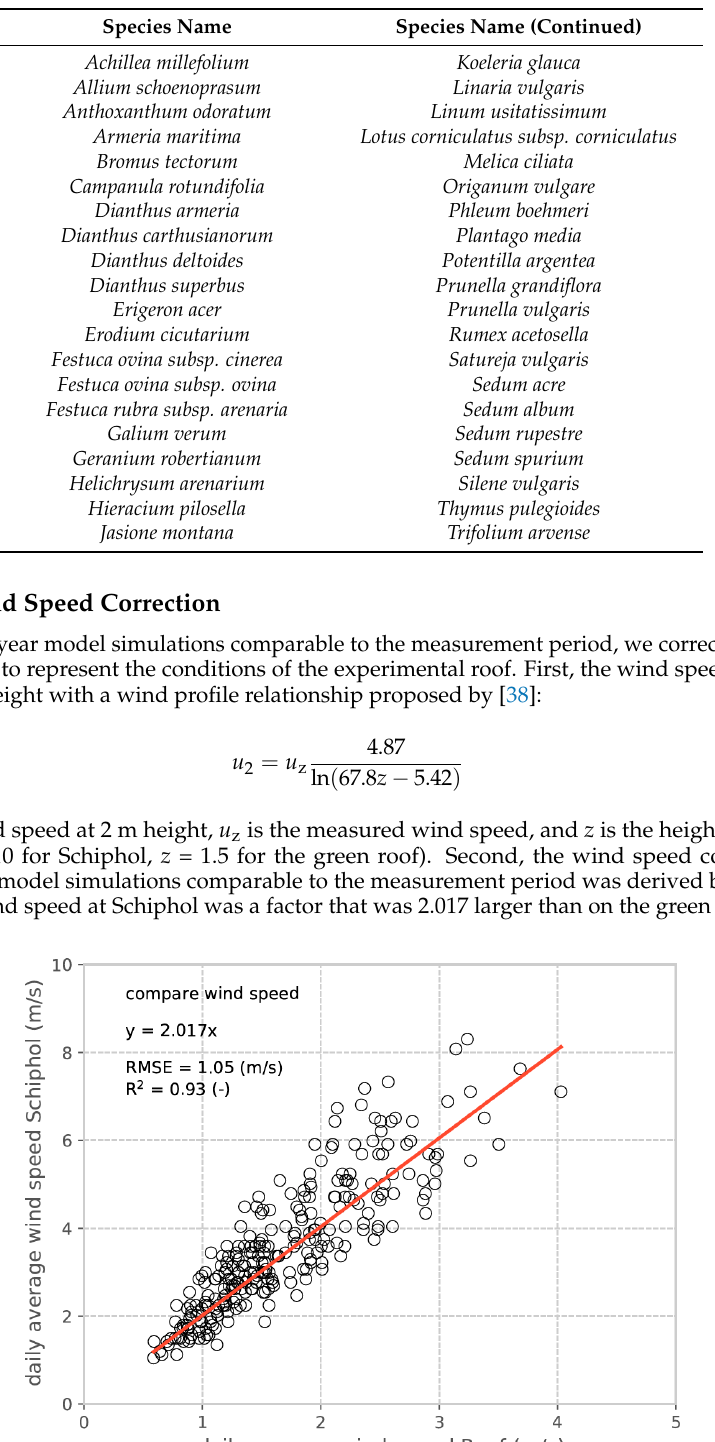
Table A1. Plant species sown on the roof.